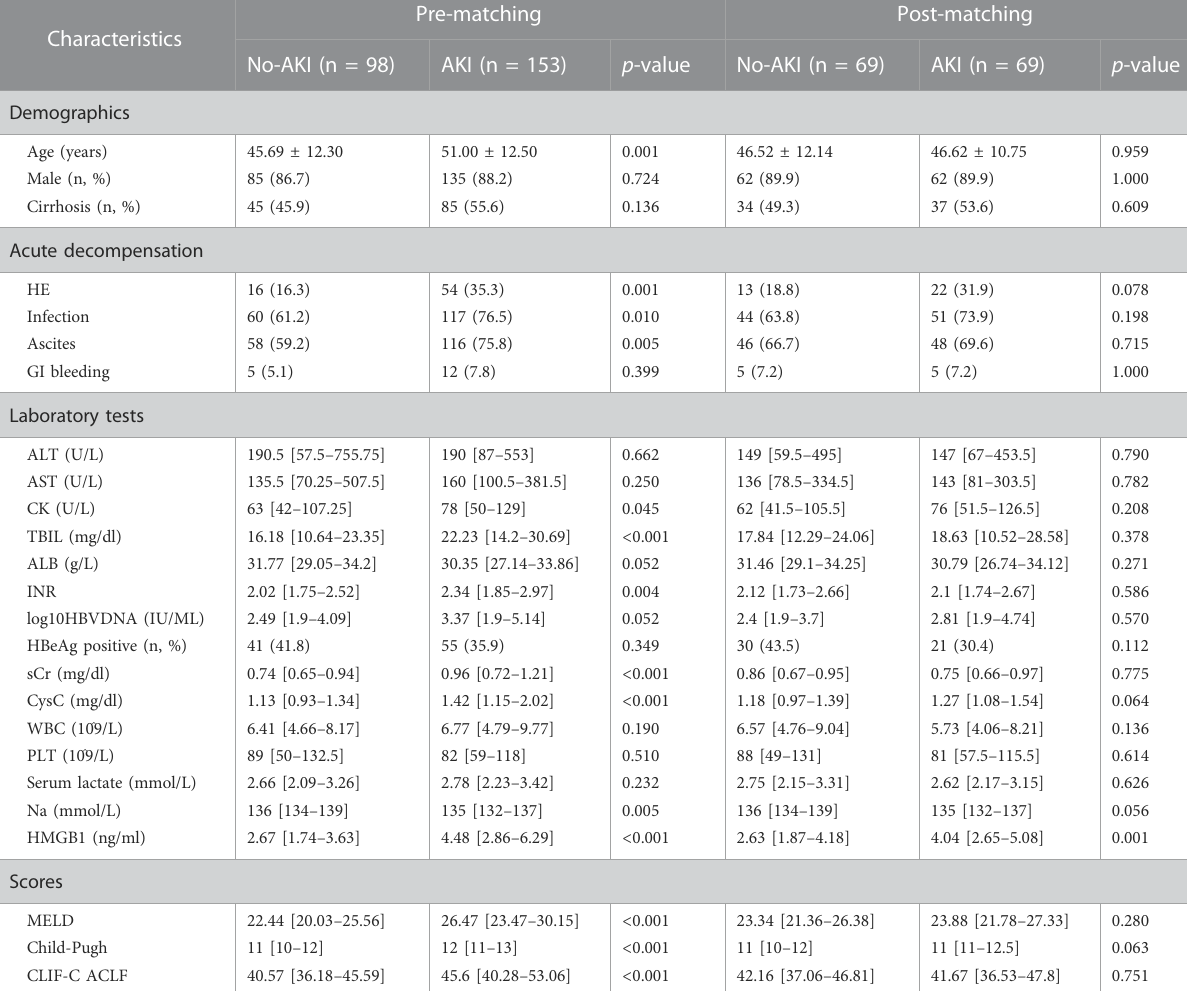
TABLE 2Characteristics of251pre-matchingor 138post-matchingACLF patients (1:1propensity score matching (No-AKI: AKI), covariables age, ascites,CysC, sCr, and CLIF-C ACLF score).